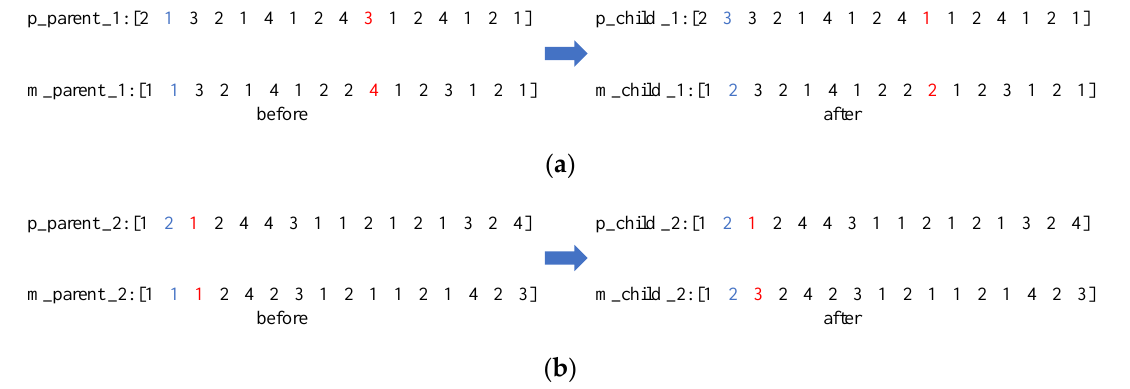
Figure 13. Crossover: ( a ) Crossover of the process chromosome; ( b ) Crossover of the machine tool chromosome.